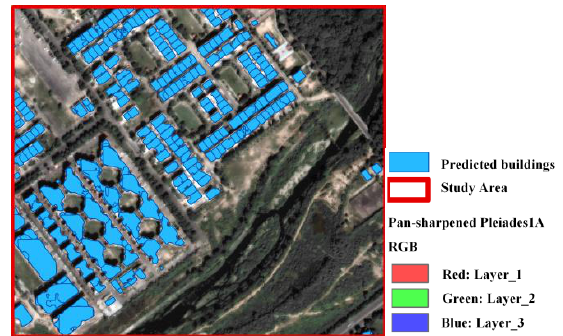
Figure 17. Building footprint extraction on Pleiades 1A RGB data using the Model